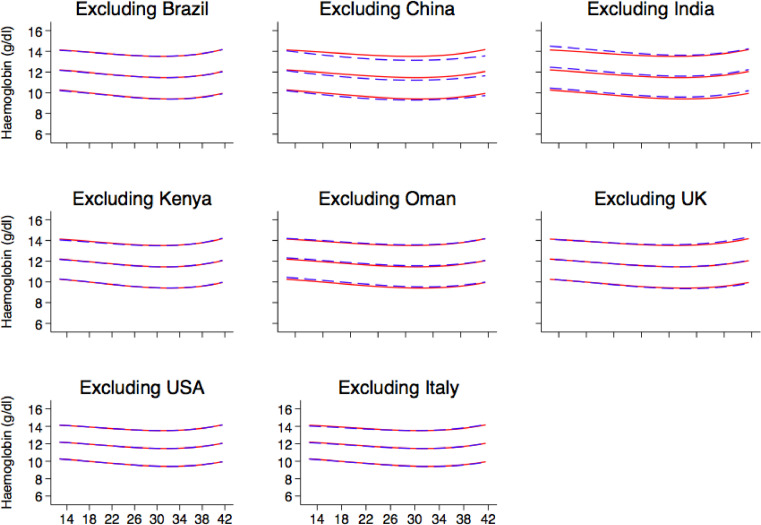
represents sensitivity analyses showing the smoothed, gestational age-specific, 3rd (red), 50th (red) and 97th (red) centiles for maternal haemoglobin from the total Fetal Growth Longitudinal Study pooled sample (n = 3502) and the fitted 3rd(blue), 50th (blue), and 97th (blue) centiles after excluding maternal haemoglobin data from each country in turn. (For interpretation of the references to color in this figure legend, the reader is referred to the web version of this article.)